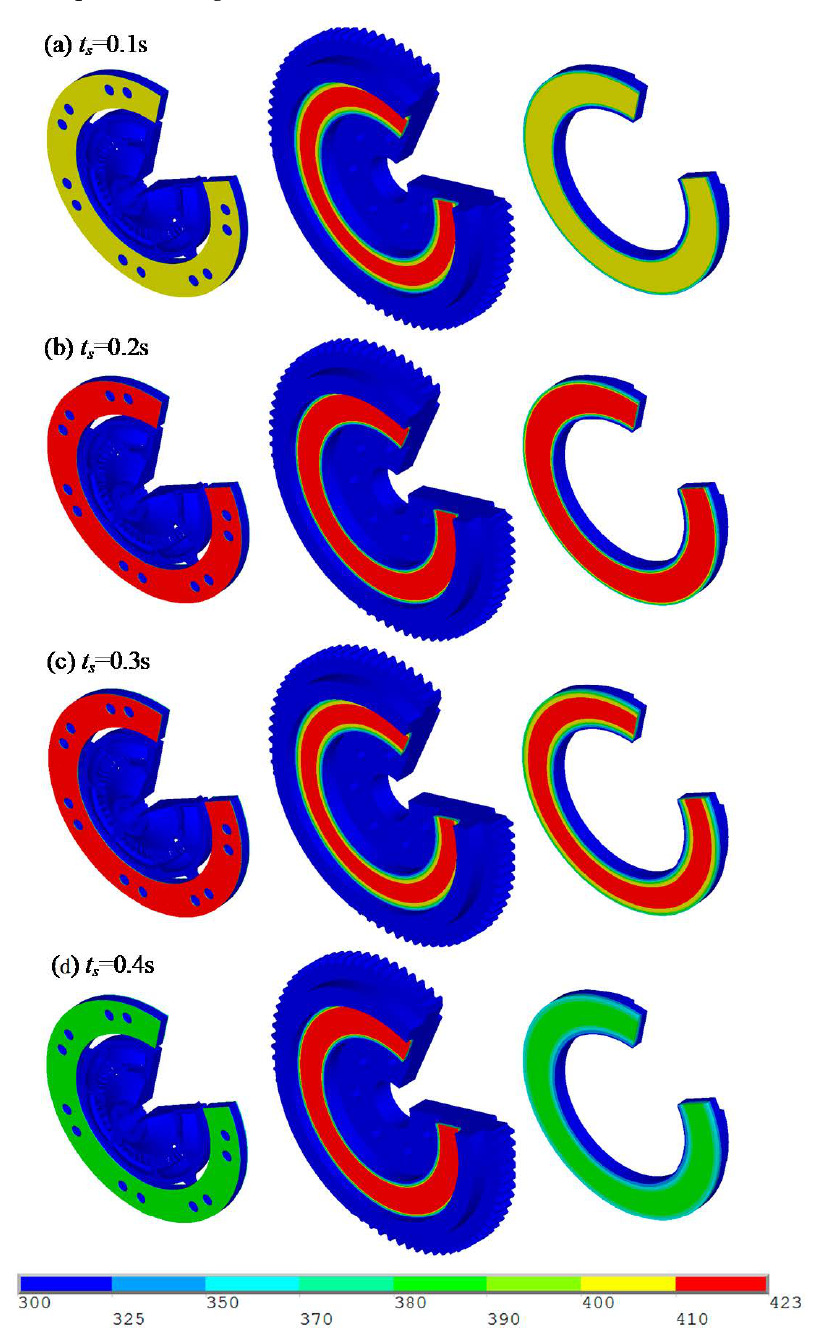
Figure 7. Highest surface temperature of clutch disc through the slipping time. Dotted–dashed line presents FE results and solid line presents analytical results (32), (38).